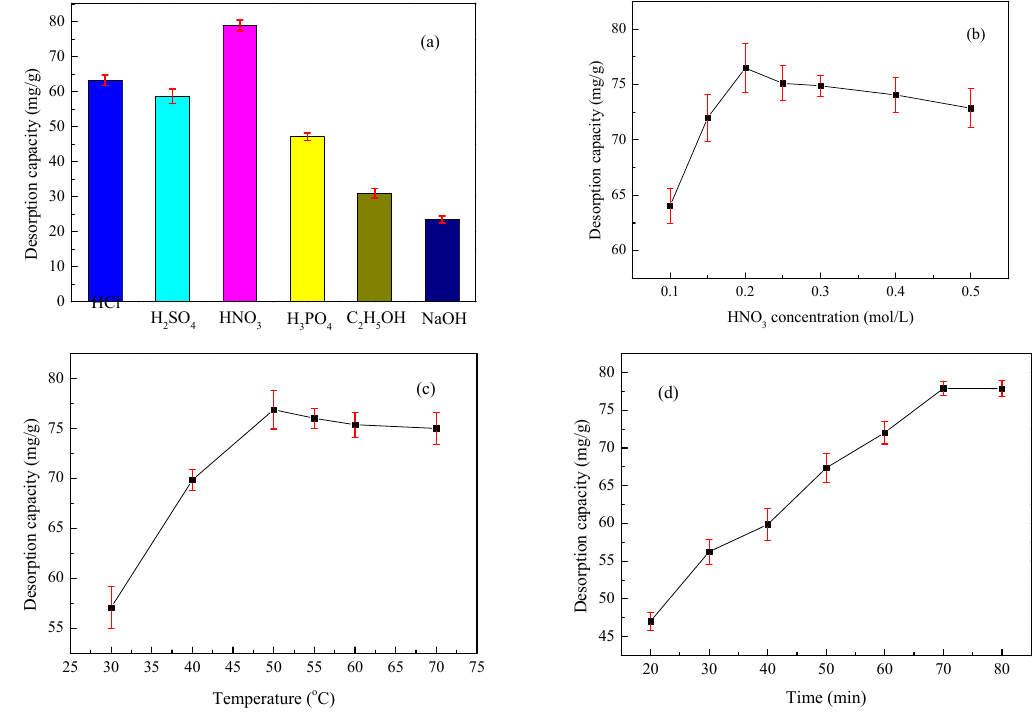
Figure 10. Effects of various desorption reagents ( a ); HNO 3 concentration ( b ); temperature ( c ) and time ( d ) on desorption capacity of XSBLAC for zinc(II). Table 5. Adsorption/desorption capacities of zinc(II) on XSBLAC after five consecutive cycles.